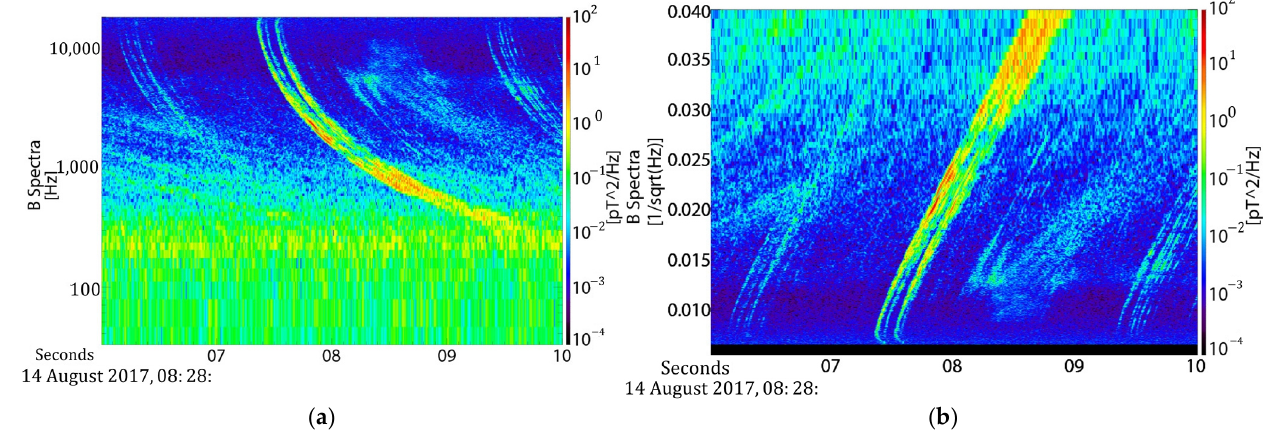
Figure 7. Lightning whistler observed by the Arase satellite on 14 August 2017 at 08:28:06–08:28:10 UT: ( a ) Dynamic power spectra of lightning whistler waves. ( b ) Converted dynamic power spectra of lightning whistler waves.